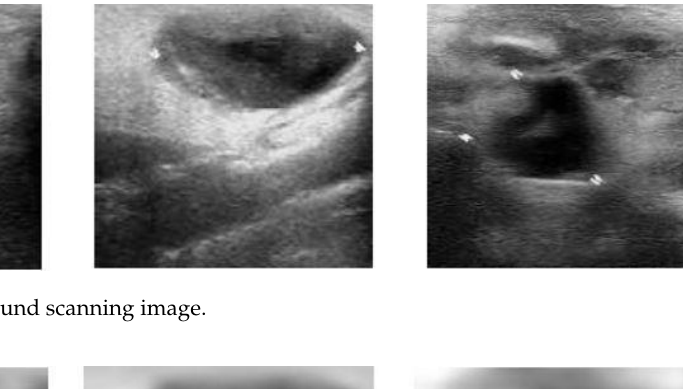
Figure 4. Original ultrasound scanning image.